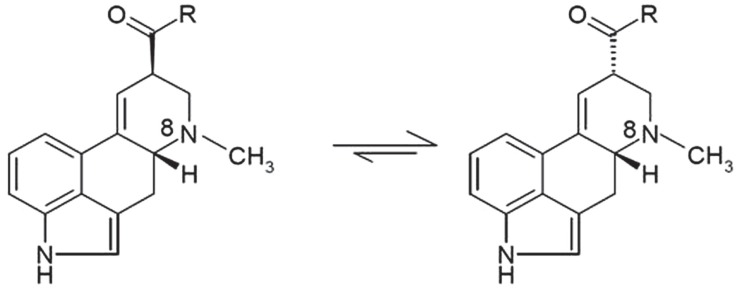
Ergot alkaloids containing C9 = C10 double bond readily epimerize at the center of symmetry C-8, adapted from Crews (36).